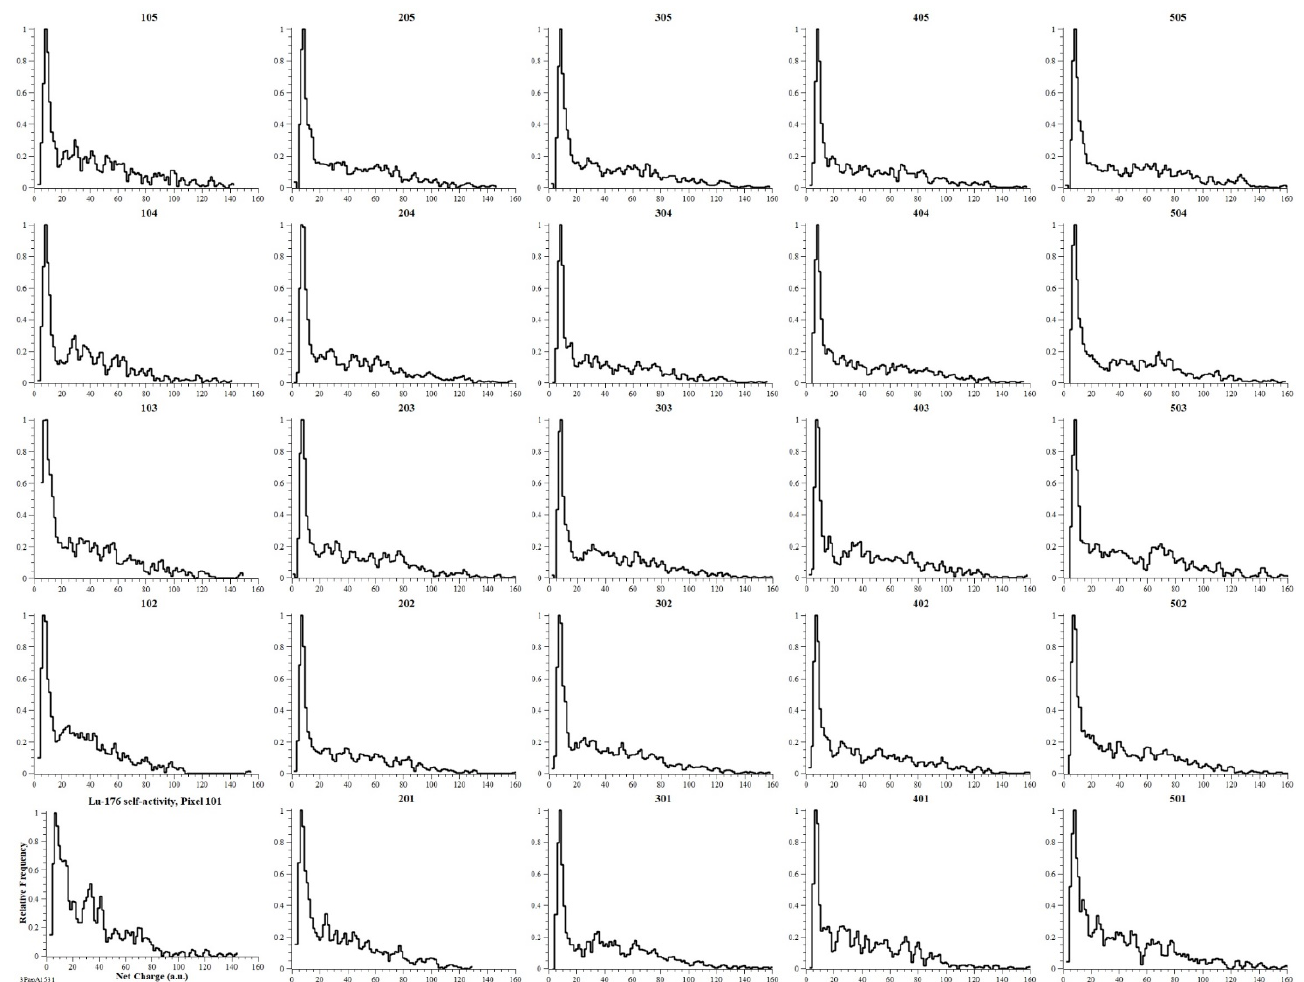
Figure A4. Lu-176 pulse-height spectra per crystal-pixel for the first quarter of the array which includes the pixels with RR ≤ 5 and CC ≤ 5. The common axes and plot descriptions are shown only once in the bottom-left frame for better clarity. Spectra have undergone denoising smoothing, and were built by using 1.5 ch.u. binning. Frequency values were normalized, pixel by pixel, to the respective maximum value.